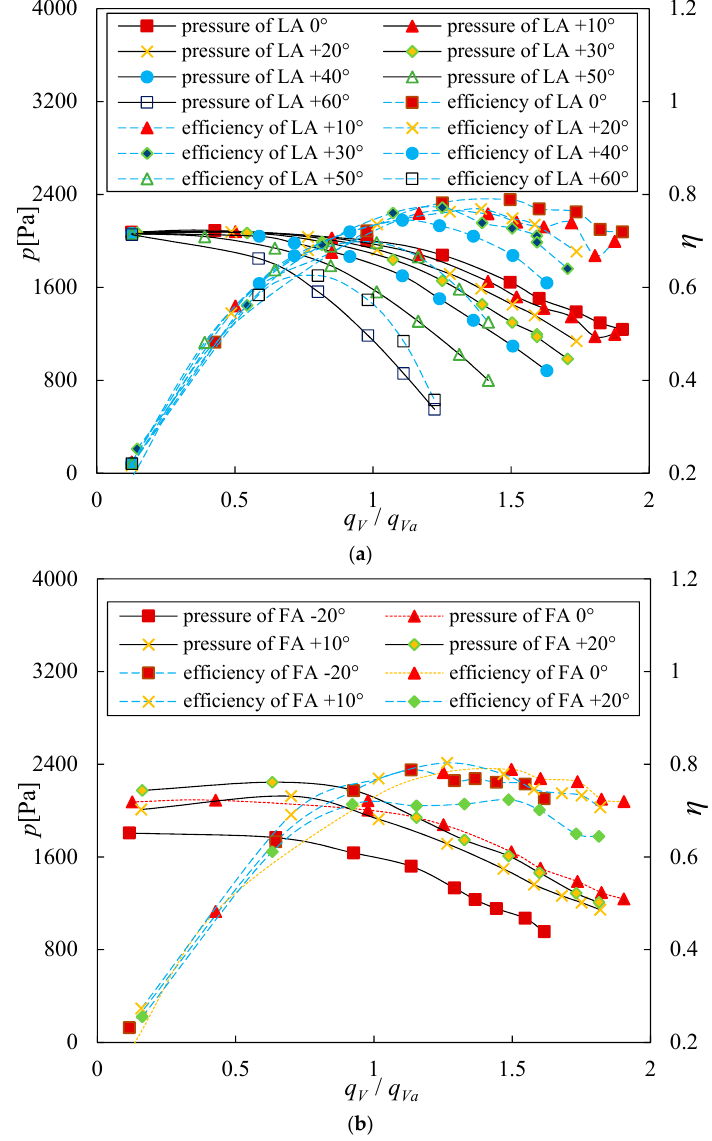
Figure 6. Experimental results about total pressure and efficiency based on ( a ) LA; ( b ) FA.